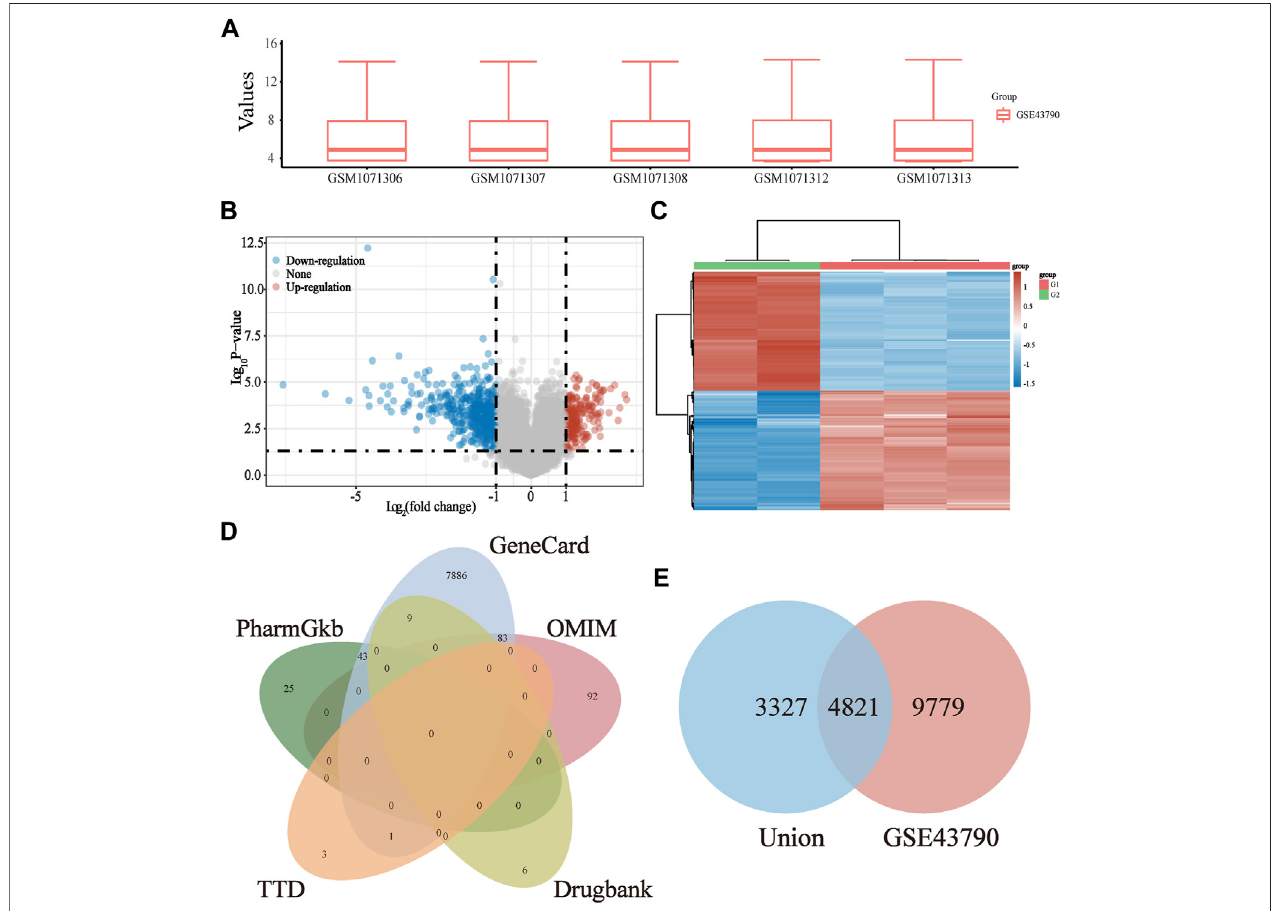
FIGURE 3 | Screening of UTI-speci fi c targets from six databases. (A) Box plot after data standardization. Rows refer to samples, and columns indicate gene expressionvaluesinthesample; (B) VolcanoplotfortheDEGofUTIswasestablishedusingthe p -value.Theredpointsintheplotmeantheupregulatedtargets,whilethe blue points represent the downregulated genes with statistical signi fi cance; (C) hierarchical clustering analysis of targets, which were differentially expressed between model and normal groups; (D) screening out the UTI-related union targets using the DrugBank, GeneCards, TTD, OMIM, and PharmGKB databases; (E) Venn diagram of the UTI GEO genes and union